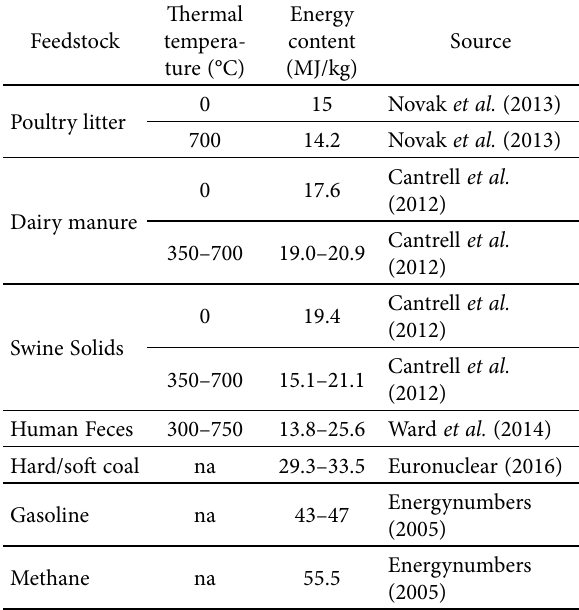
Table 2. Net thermal energy in various manures, and their biochars pyrolyzed at various temperatures, as compared to hard/soft coals, gasoline and methane. na = not available